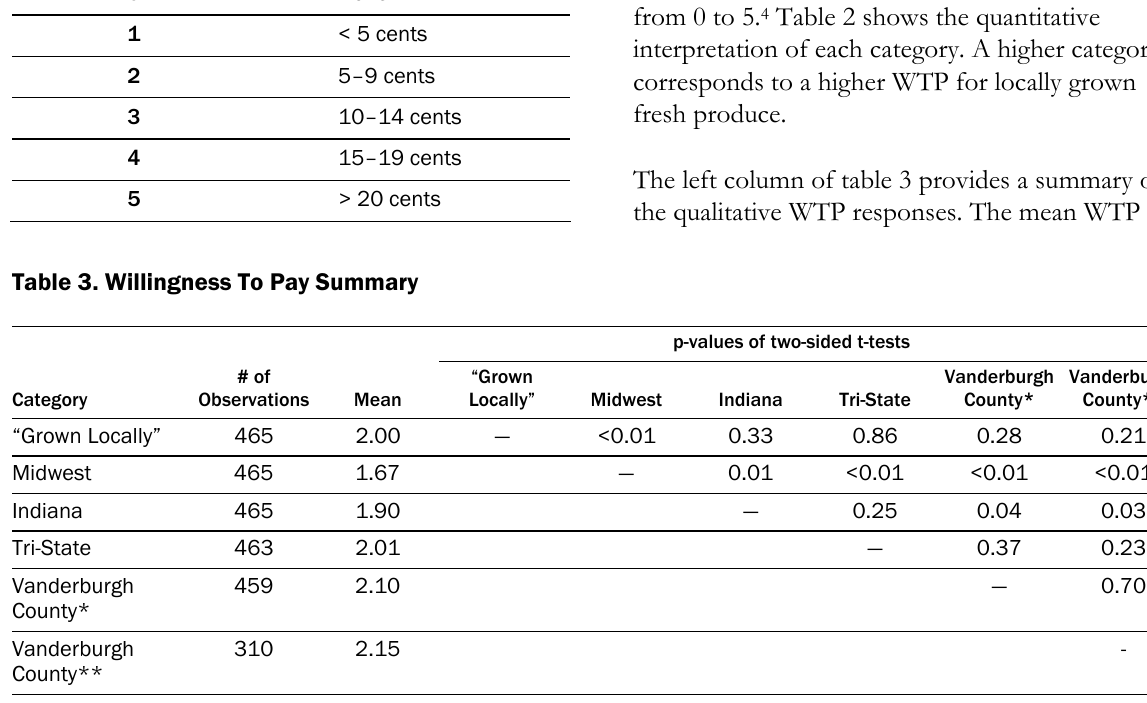
Table 2. WTP category (all values in US$ cents, where 100 cents = 1 US$) Qualitative Variable